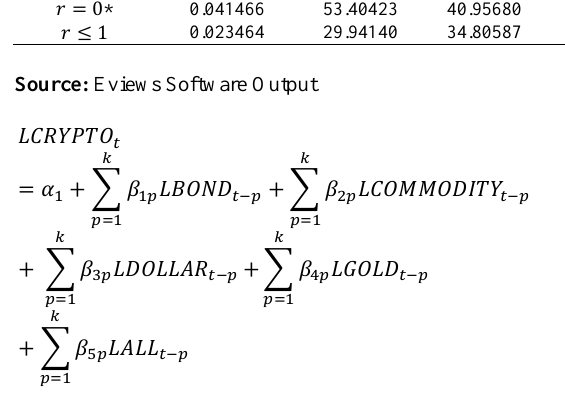
Table 3: Unit Root Tests Results